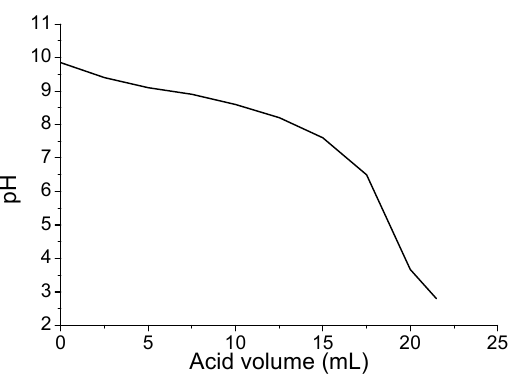
Figure 8. Neutralization curve of Mg(OH) 2 (MH) with a sulfuric acid solution (0.4 M). Figure 8. Maximum pH values obtained after 1 min of the addition of each drop (0.5 mL) of a sulfuric acid solution (0.4 M), during the neutralization of Mg(OH) 2 (MH) (for more information see